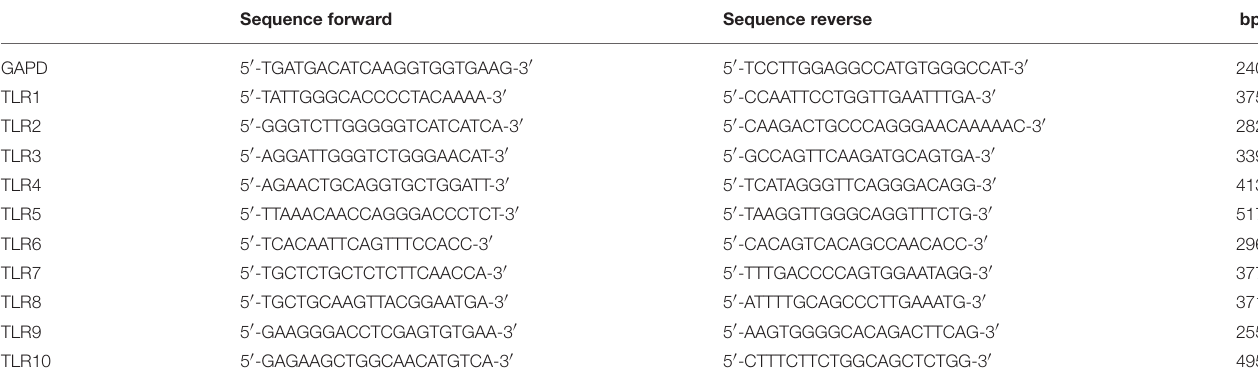
TABLE 1 | GAPDH and TLR-specific primer